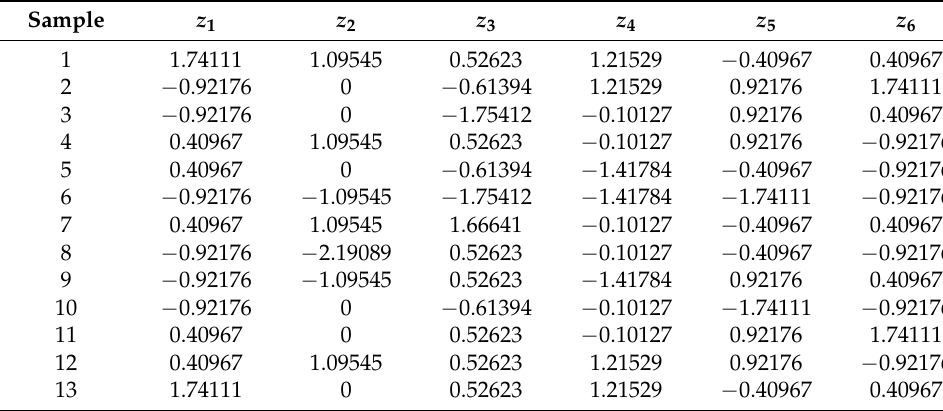
Table 10. Standardized results of sample